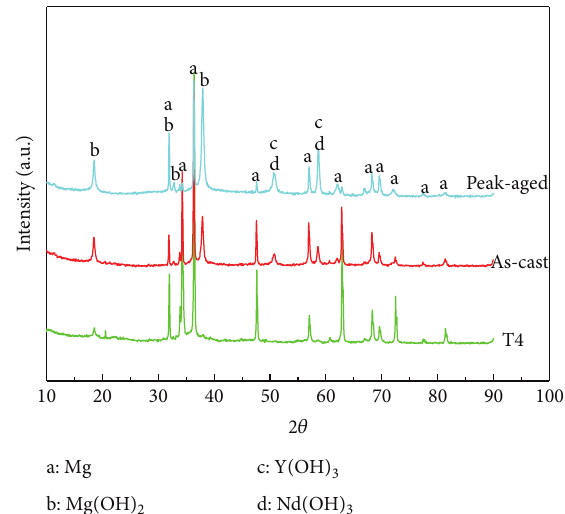
Figure 5: The XRD of corrosion products formed on different sam-